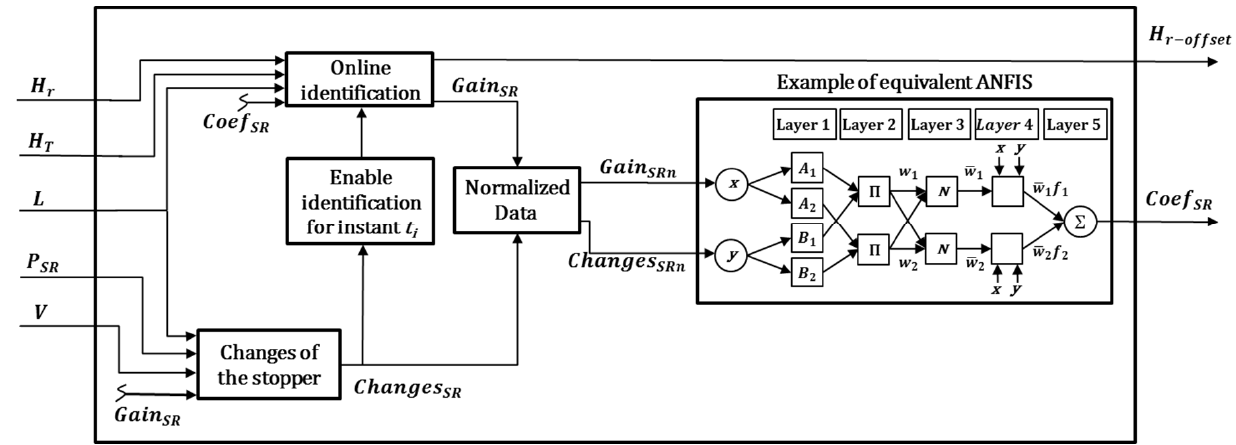
Figure 5. Block diagram of the subsystem applied for compensating the stopper gain variations.